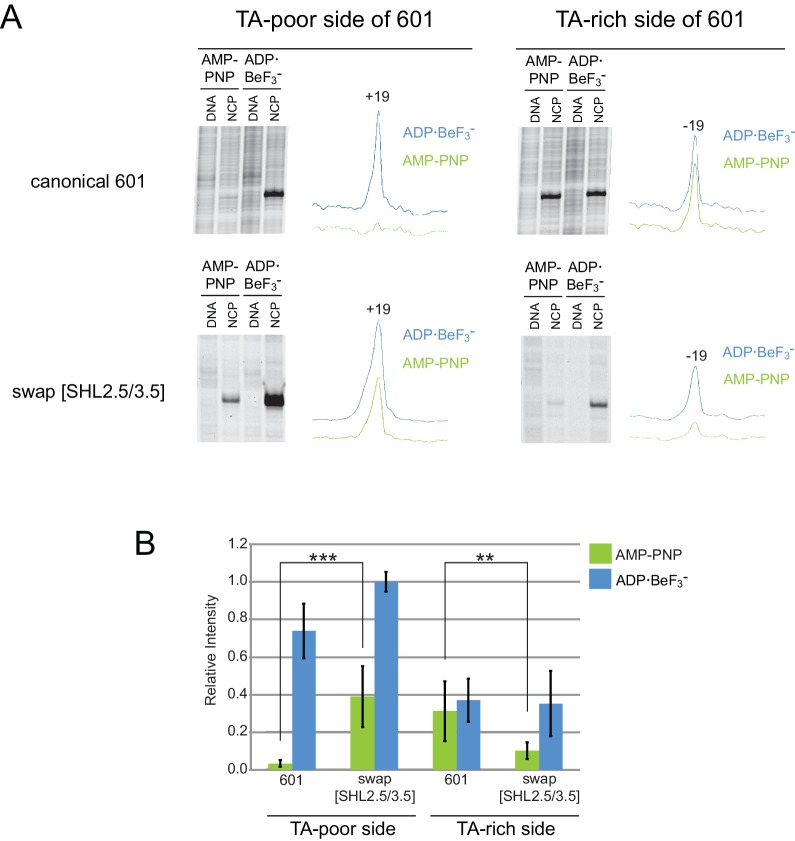
Distinct TA-poor and TA-rich Chd1 cross-linking patterns are transposed on the 601[swap SHL2.5/3.5] nucleosome.(A) Chd1(V721C) cross-linking reactions on the Widom 601 and 601[swap SHL2.5/3.5] nucleosomes in AMP-PNP and ADP·BeF3– conditions. The Widom 601 nucleosome has reduced cross-linking on the TA-poor side when compared to the TA-rich side, whereas the 601[swap SHL2.5/3.5] nucleosome reverses this trend with diminished cross-linking on the TA-rich side compared to the TA-poor side. Each trace represents the intensity profile of the corresponding NCP gel lane, obtained using ImageJ. (B) Quantification of Chd1(V721C) cross-linking data. The area of each peak was calculated in ImageJ (RRID: SCR_003070), scaled according to background peaks, and normalized against a 601[swap SHL2.5/3.5] sample in ADP·BeF3– . Error bars signify the standard deviations from three or more experiments. The differences in Chd1 cross-linking in AMP-PNP for canonical 601 versus 601[swap SHL2.5/3.5] are statistically significant (** p-value < 0.01, *** p-value ≤ 0.001).